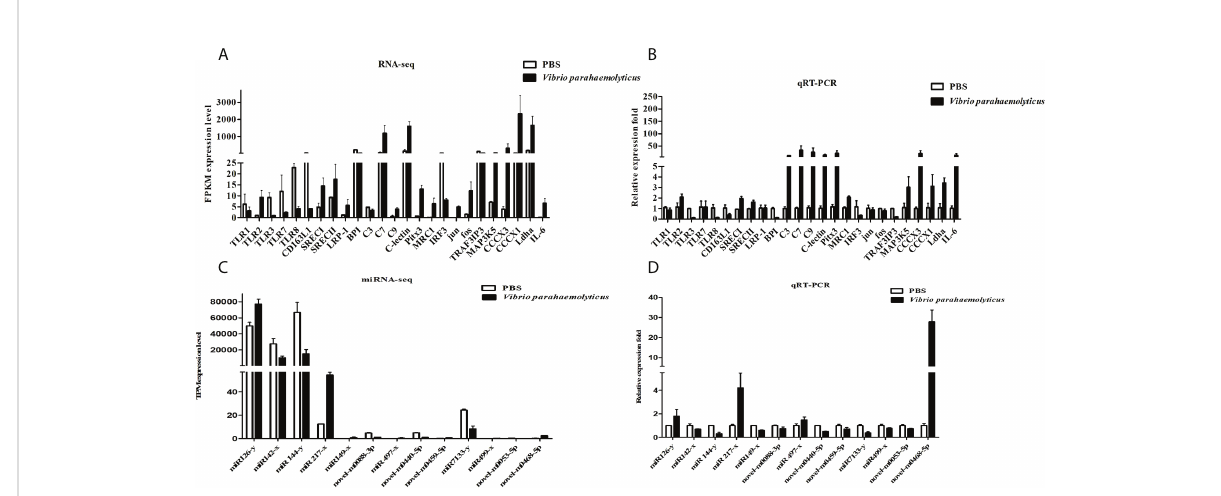
FIGURE 6 Veri fi cationofthesequencingresultsusingqRT-PCRanalysis. (A) Relevantpatternrecognitionreceptors, signal moleculesandcytokinesinmRNA-seq. The abscissaindicatesthe names of theDEGs, andthevertical coordinaterepresentsthe FPKM value . (B) Relevantpattern recognitionreceptors, signal moleculesand cytokineswereveri fi edby qRT-PCR veri fi cation. Theabscissaindicatesthenamesof the DEGs,and theverticalcoordinate representsthe foldchange. (C) Selected differential expressedmiRNAsweredetectedinmiRNA-seq.The abscissaindicatesthe namesof theDEMs, andthevertical coordinaterepresentsthe TPMvalue . (D) Selecteddifferential expressed miRNAwere veri fi edbyqRT-PCR. Theabscissaindicatesthenamesofthe DEMs, and theverticalcoordinate representsthe